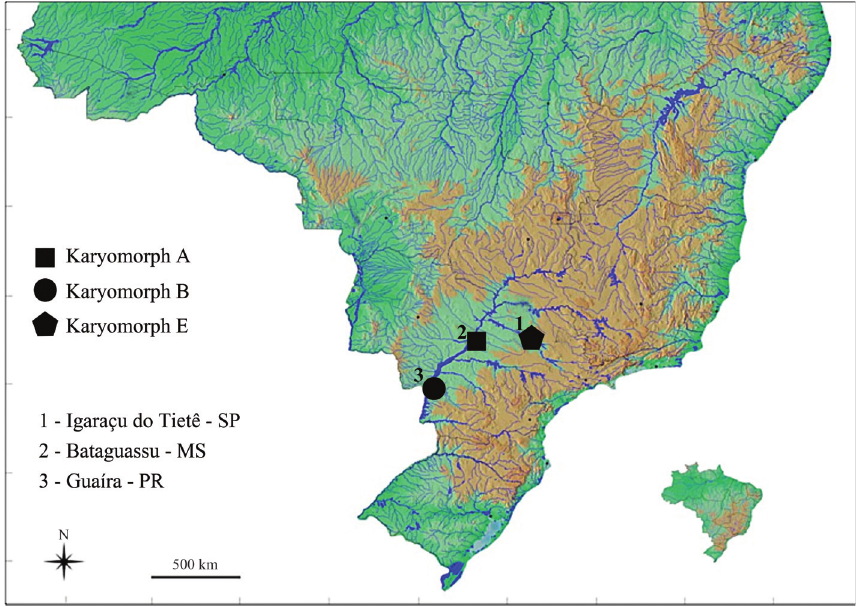
Figure 1 - Map showing the S . marmoratus specimen collection sites. The numbers indicate the sample locality, while symbols represent the karyo- morphs found in each locality.